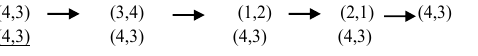
Figure 1. An attempt by player 2 to exit the state (4, 3) by changing its strategy (an analysis based on backward induction). Source: own compilation. The theory of moves offers a different basis for making individualistic calculations of noncooperative game theory compared to the standard theory. It explains strategically the progression of states that lead to a more permanent outcome. If the game starts (as in the analyzed case) in a state, at which players accrue payoffs and they remain in that state, it becomes the outcome of the game.